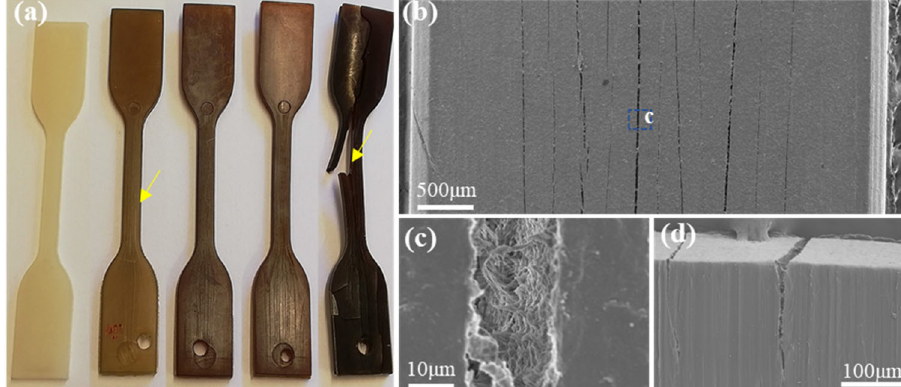
Fig. 4 Surface cracks on PA12 samples. a Images of PA12 samples (from left to right, samples with an ageing time of 0, 150, 300, 500, and 700 h) and SEM images of the surface of the 150 h-aged sample ( b , c ) and the cross-section of the middle crack ( d